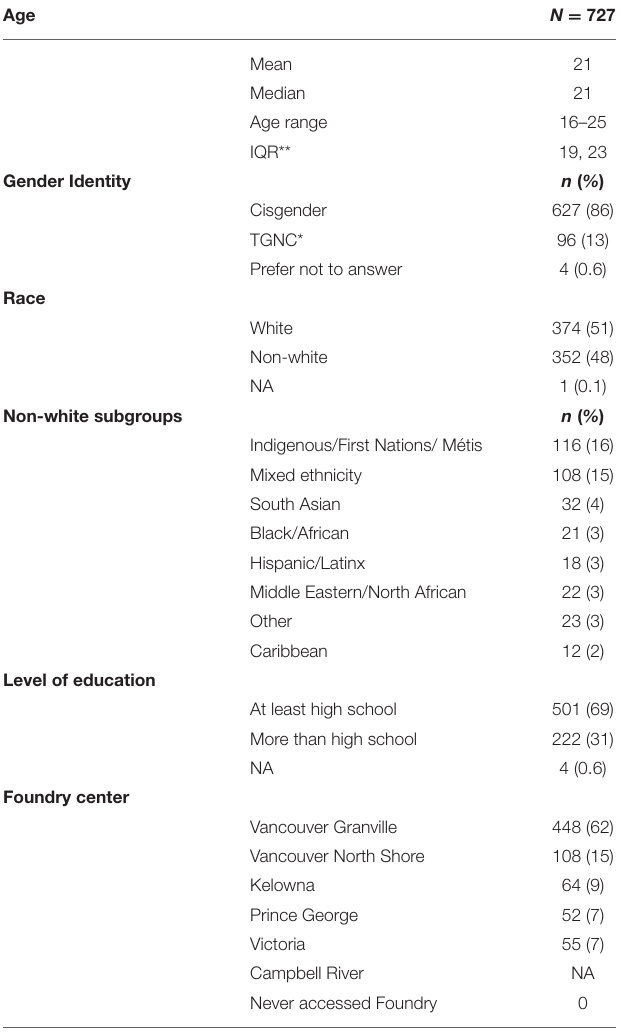
TABLE 1 | Characteristics of study